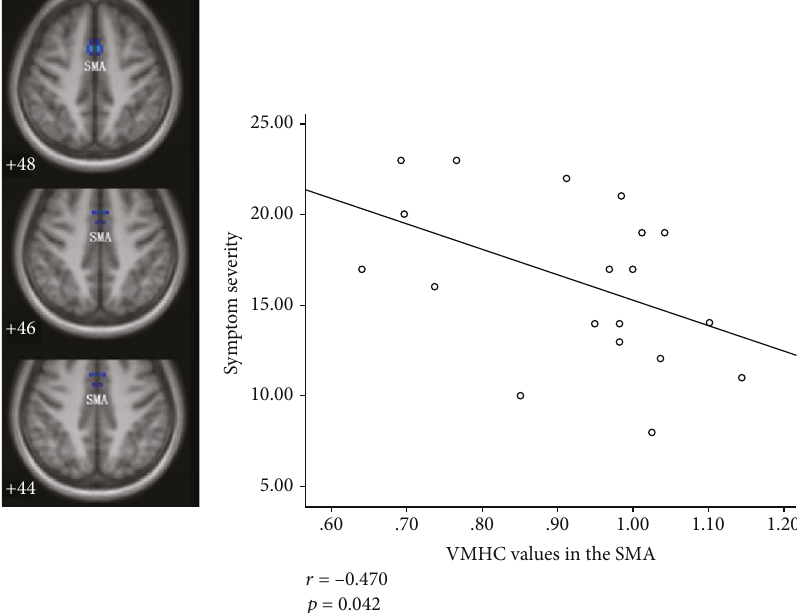
Figure 4: Correlation between the VMHC values in the SMA and symptom severity in the patient group. VMHC=voxel-mirrored homotopic connectivity; SMA=supplementary motor